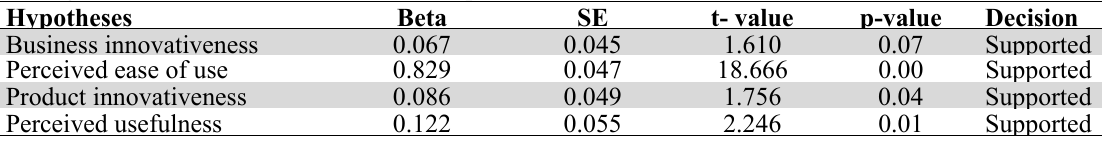
Fig. 4. Structural Model Testing results of main effect structural equation